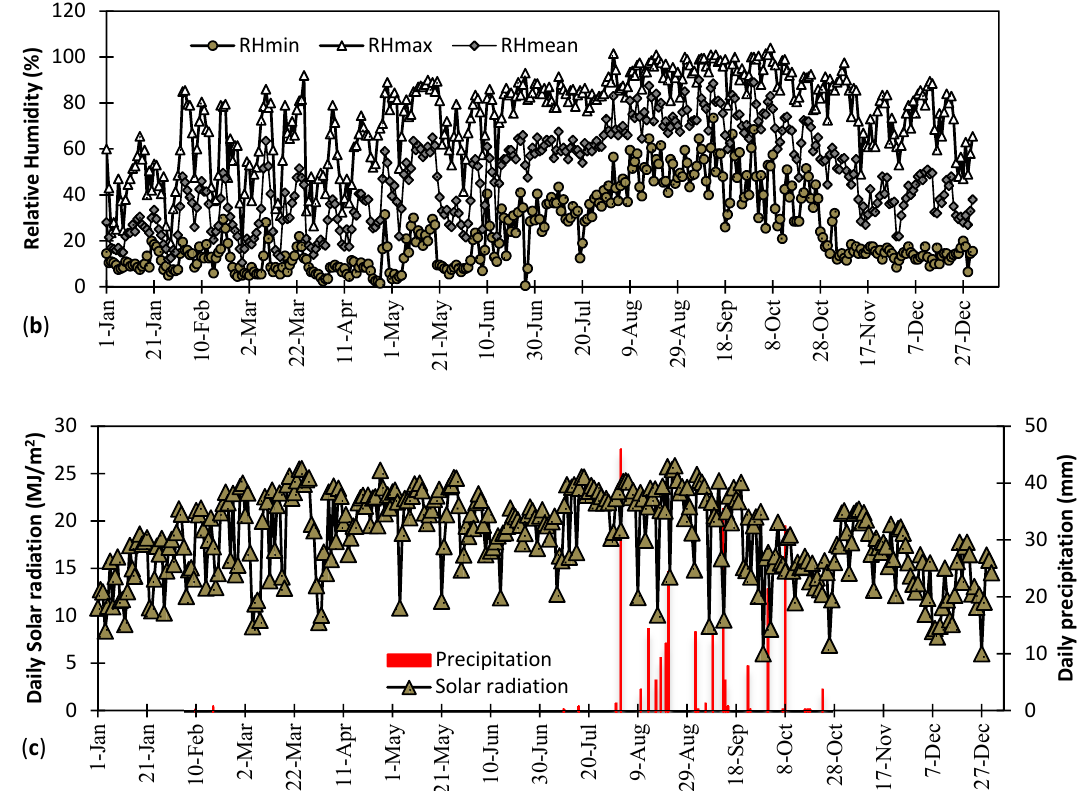
Figure 1. Variation of the ( a ) daily maximum, minimum and average temperature, ( b ) daily maximum, minimum and average relative humidity, and ( c ) daily solar radiation and precipitation from 1 January to 31 December 2015.